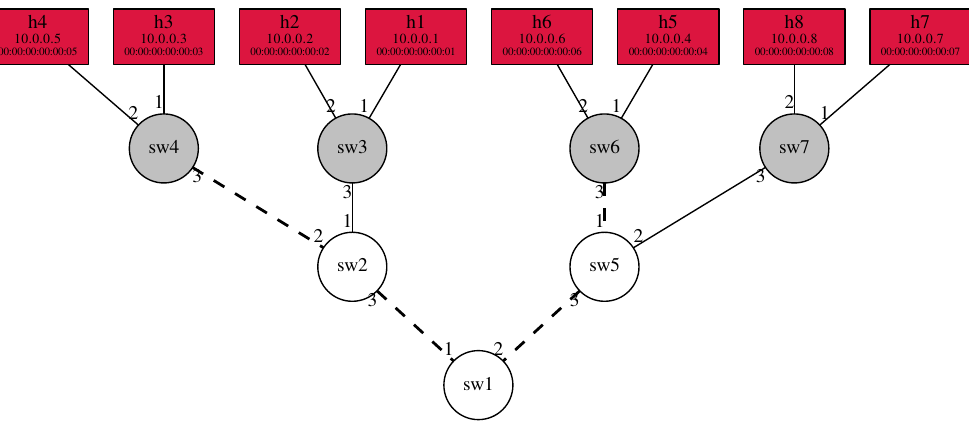
Figure 12. Failing links as identified by the framework in the layout difference